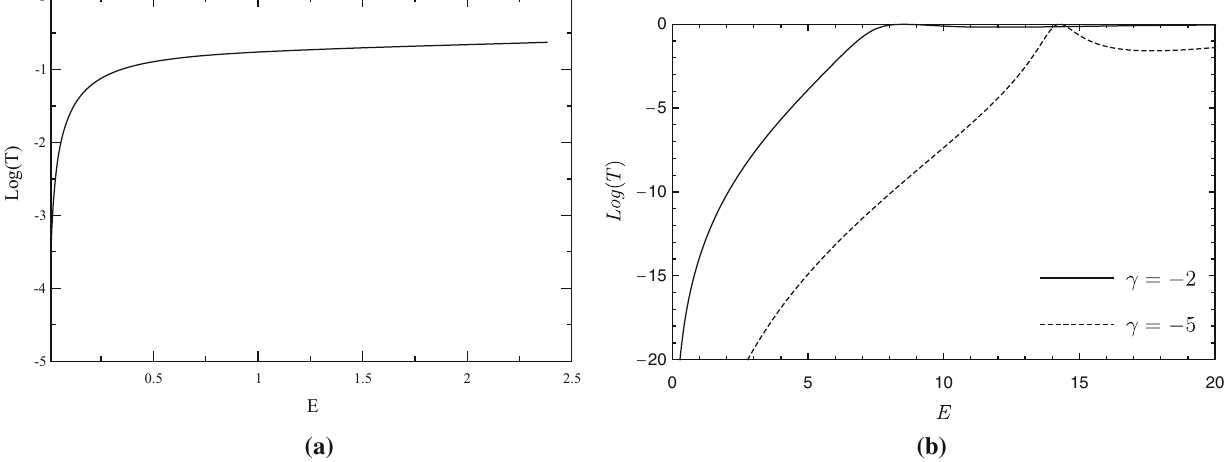
. a Ricci coupling and b Einstein coupling T